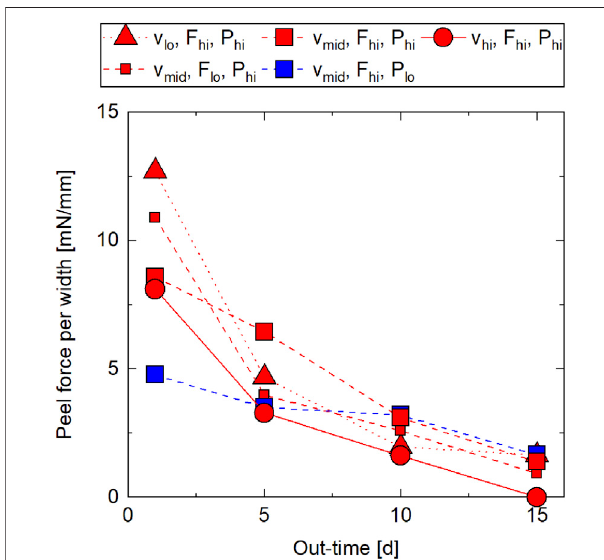
FIGURE 8 | Peel tack results as a function of out-time from TUM peel tack tests (Material: IM7/8552 prepreg; out-time: 1 day – 15 days at T (cid:1) 21 ° C , RH (cid:1) 40 % ; v lo (cid:1) 0 . 03 m / s , v mid (cid:1) 0 . 06 m / s , v hi (cid:1) 0 . 1 m / s , F lo (cid:1) 200 N , F hi (cid:1) 400 N , P lo (cid:1) 150 W , P hi (cid:1) 350 W ).